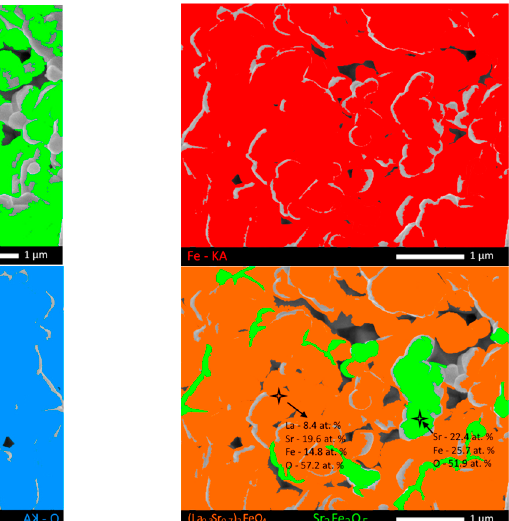
Table 2. Structural parameter data.